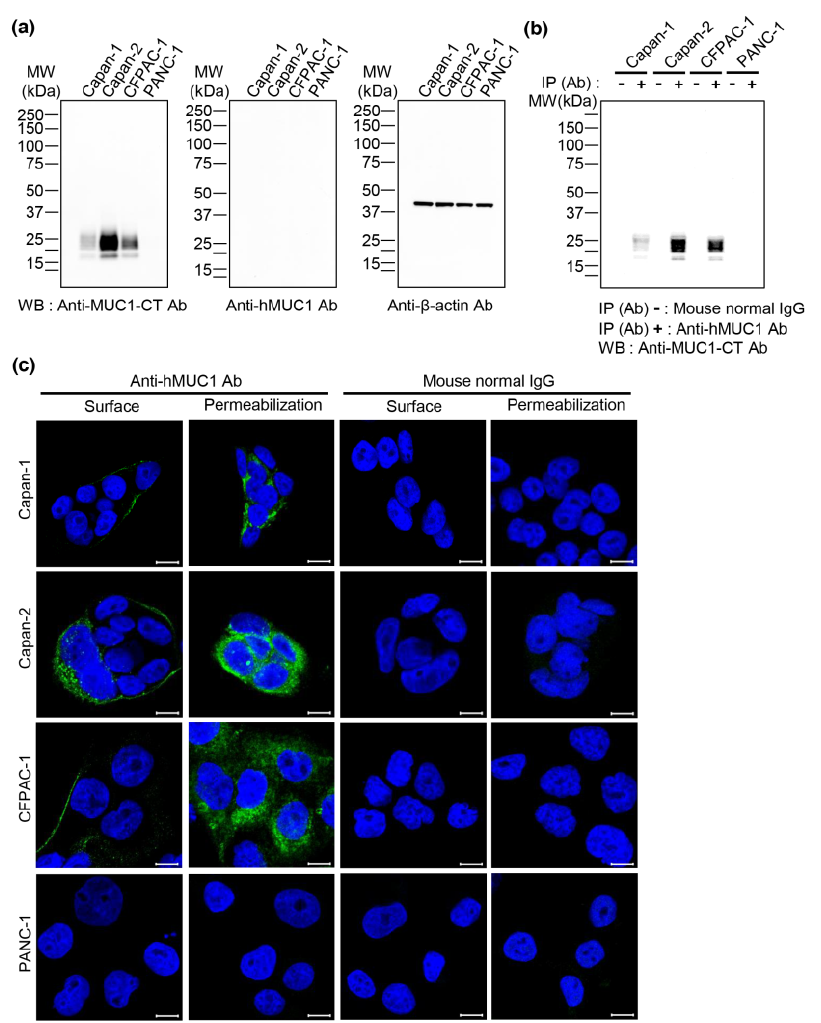
Figure 1. Immunoreactivity of anti-hMUC1 monoclonal antibody in pancreatic cancer cells. ( a ) Lysates from the pancreatic cancer cell lines Capan-1, Capan-2, CFPAC-1 and PANC-1 were analyzed by western blotting using anti-MUC1-CT, anti-hMUC1 and anti- β -actin antibodies. ( b ) Capan-1, Capan-2, CFPAC-1 and PANC-1 cell lysates were immunoprecipitated with mouse normal IgG or anti-hMUC1 monoclonal antibody followed by western blotting using anti-MUC1-CT antibody. ( c ) Capan-1, Capan-2, CFPAC-1 and PANC-1 cells were fixed with 4% paraformaldehyde and incubated with mouse normal IgG or anti-hMUC1 monoclonal antibody on ice to identify MUC1-C on the membrane surface of the cells (surface). On the other hand, to identify MUC1-C in the intracellular region, the cells were fixed, permeabilized and incubated with mouse normal IgG or anti-hMUC1 monoclonal antibody at